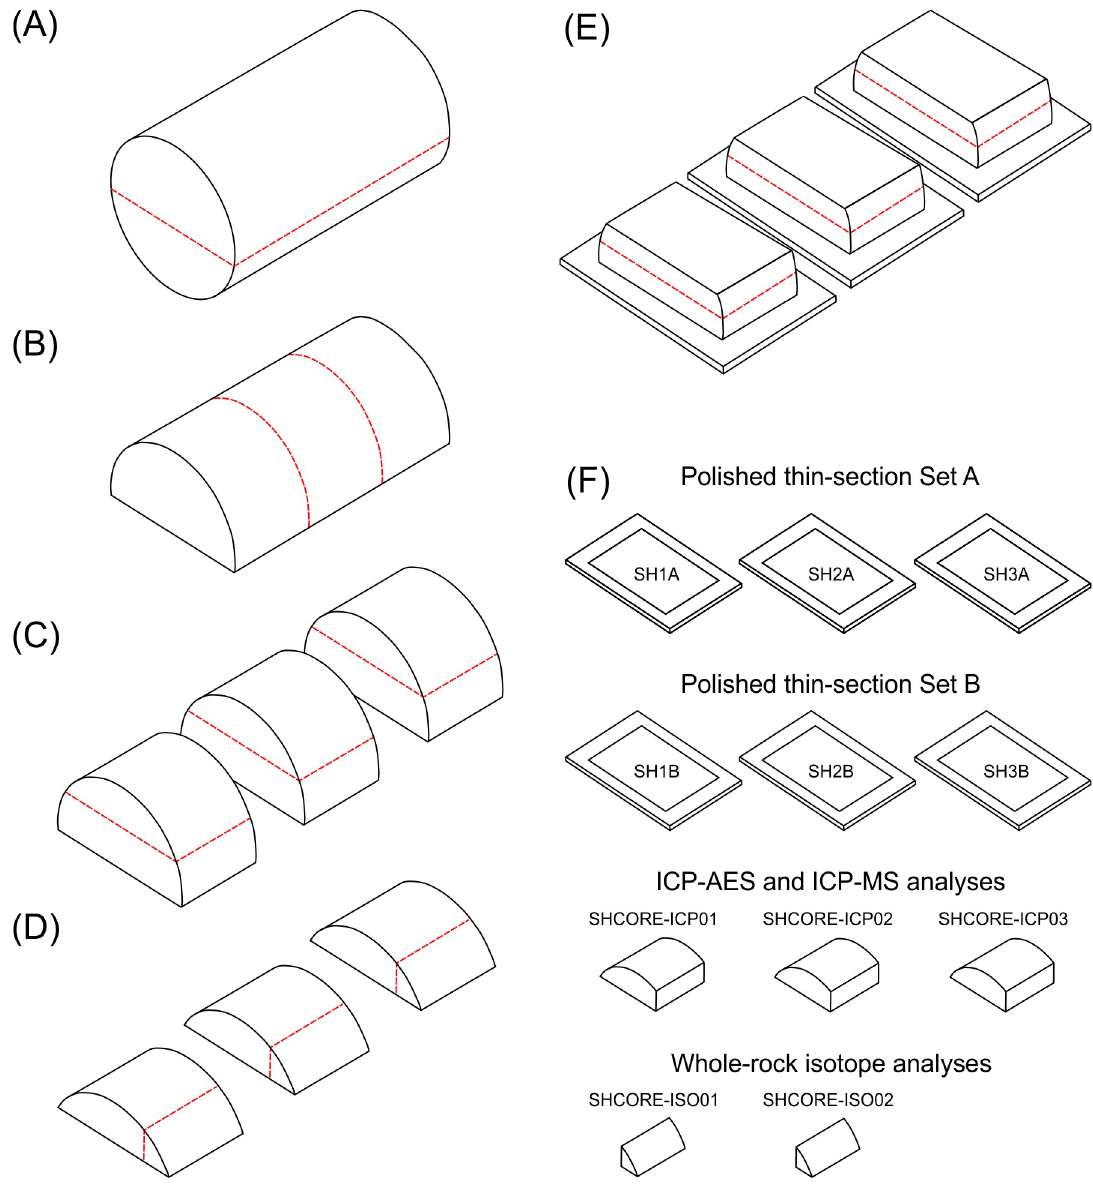
Fig 6. Schematic representation showing how the 67 mm long section 2–3 of the Phillips’ Core from Stone 58 at Stonehenge was (A) cut (dashed lines) and prepared (B-E) in order to produce two sets of three polished thin sections, three samples for whole-rock major and trace element analysis, and two samples for whole-rock isotopic analysis (F). See text for full